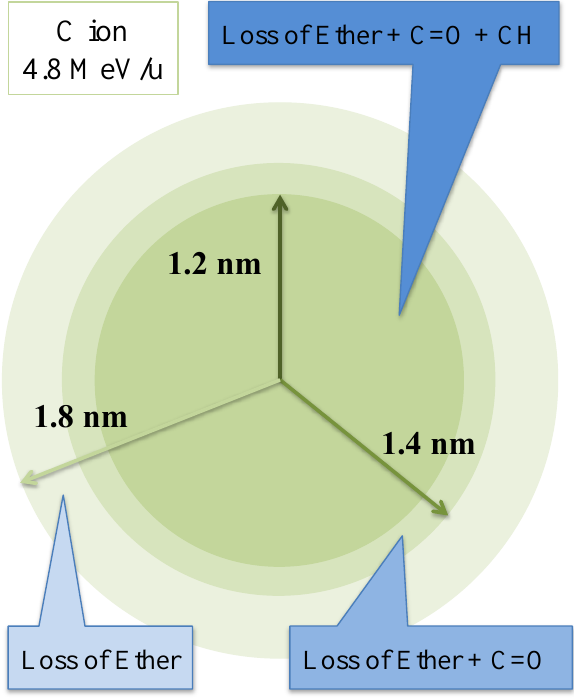
Figure 6. Layered structure of C ion track with an energy of 4.8 MeV/u.